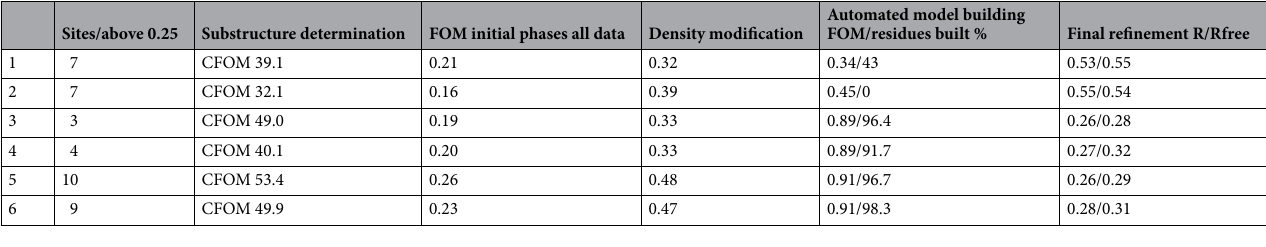
Table 9. Phasing and structure solution data for p62